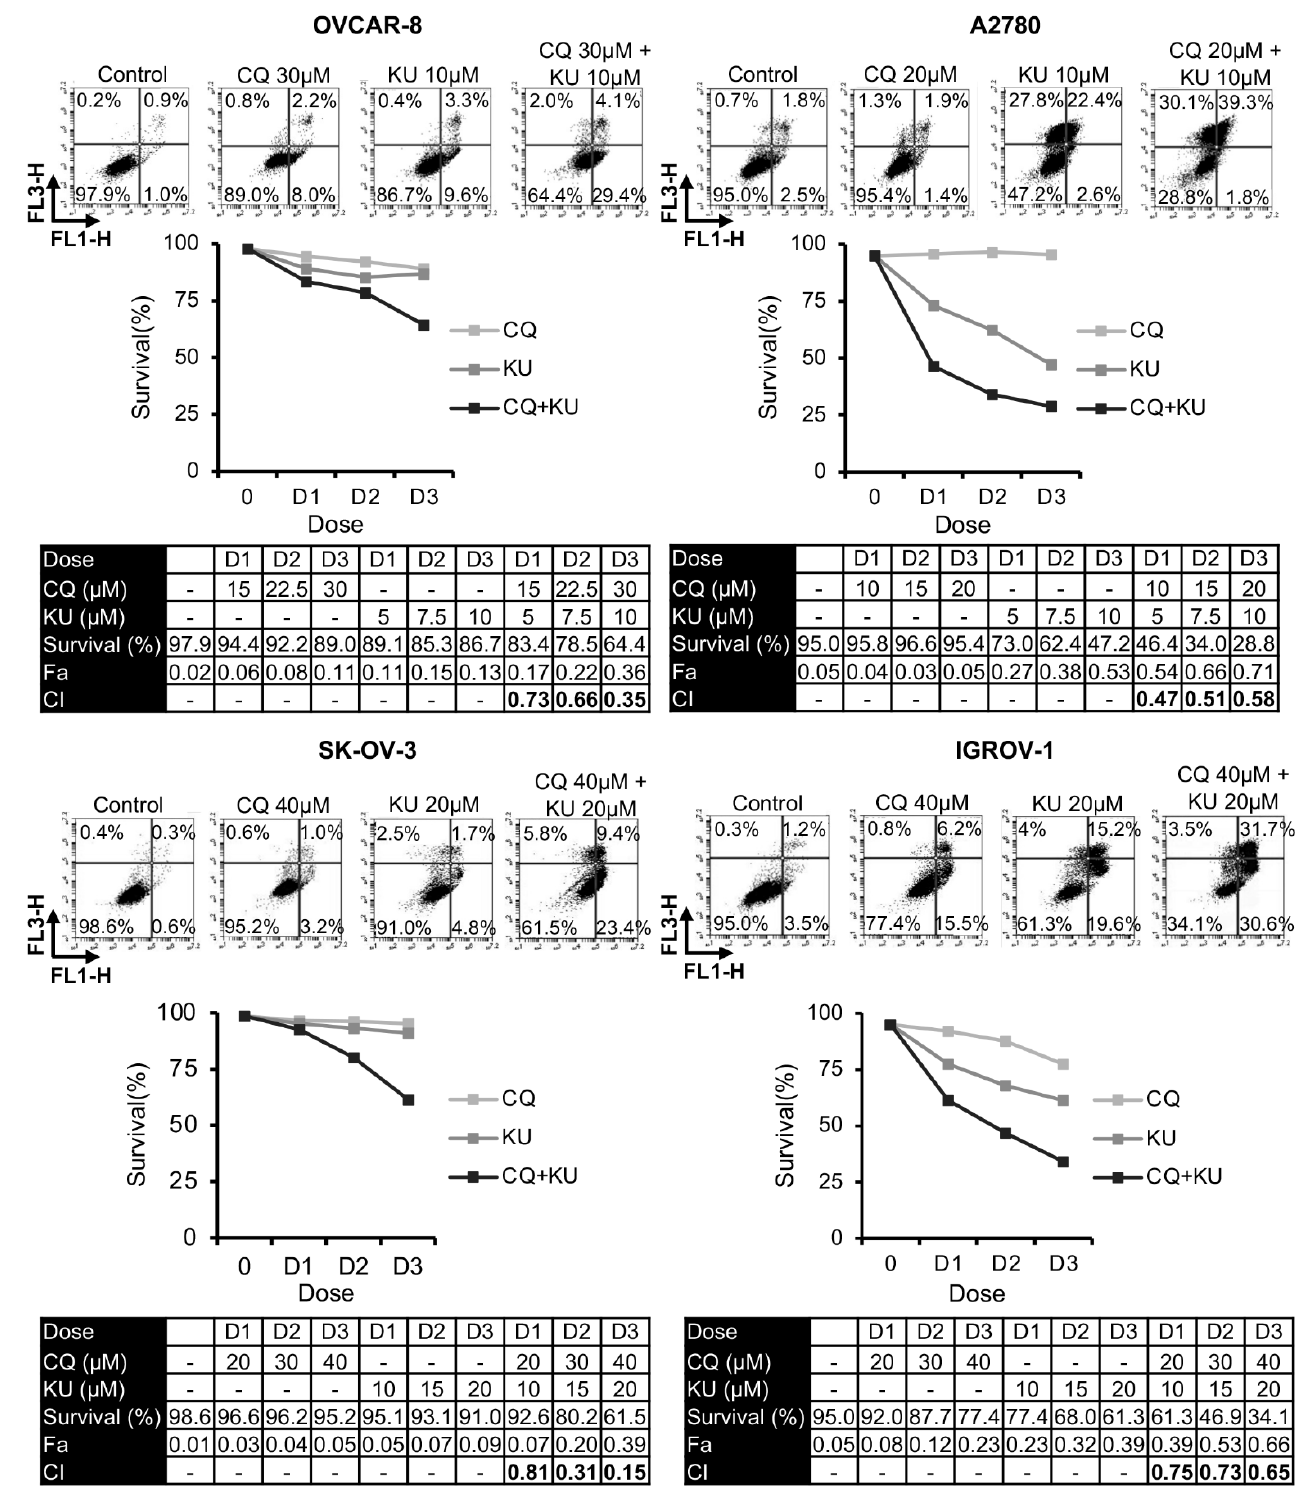
Figure 4. Synergistic effect of chloroquine and KU-57788 in OCCLs. Cells were exposed for 72 h to the indicated concentrations of KU and CQ at a constant ratio, and the percentage of apoptotic cells was assessed by flow cytometry (after cell staining with annexin V and propidium iodide). CI values, calculated using Compusyn Software (version 1.0), are shown.